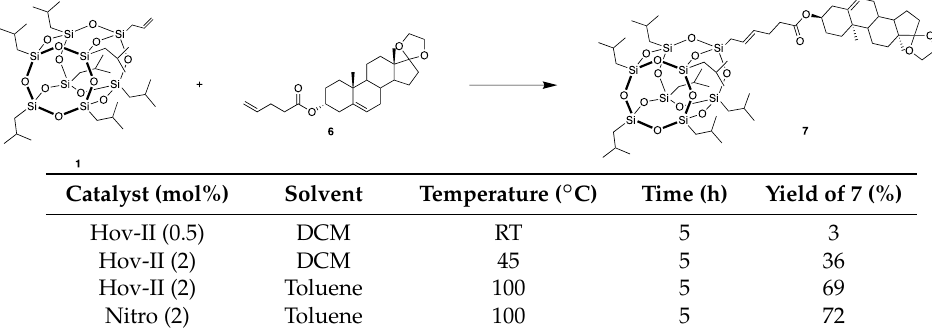
Table 2. Cross metathesis of allyl-POSS 1 with derivative of androsterone 6 .